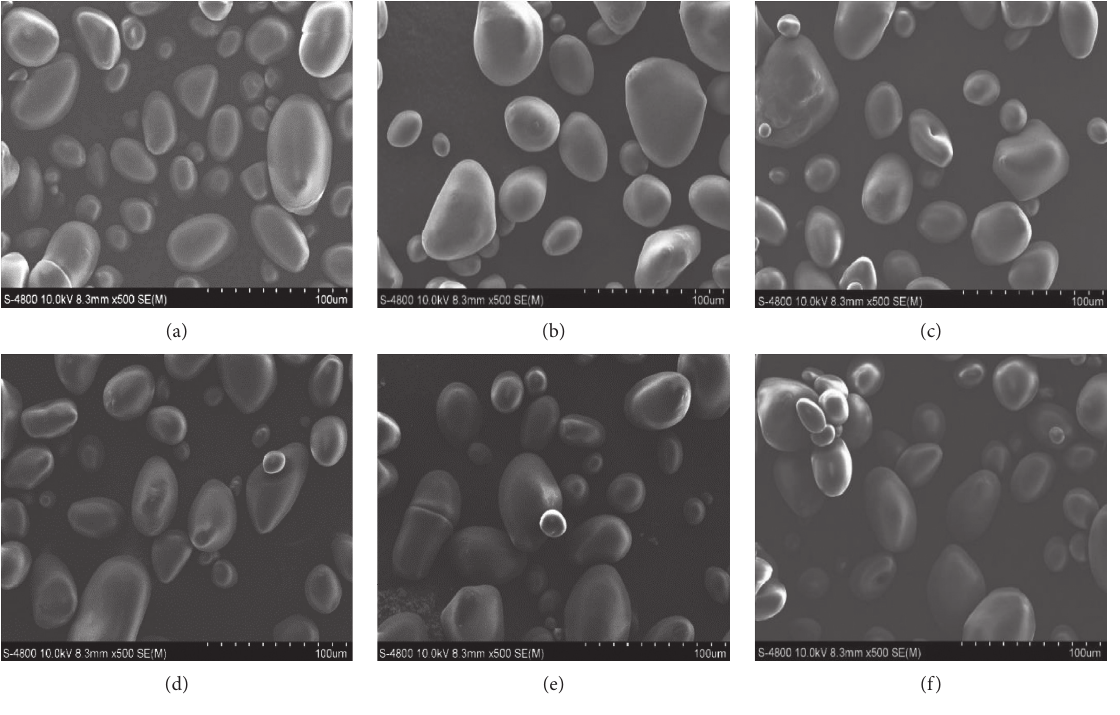
Figure 2: Scanning electron micrographs of starch samples: (a) CT11.74; (b) EB11.74; (c) EB14.84; (d) EB17.51; (e) EB19.24; (f) EB28.94.